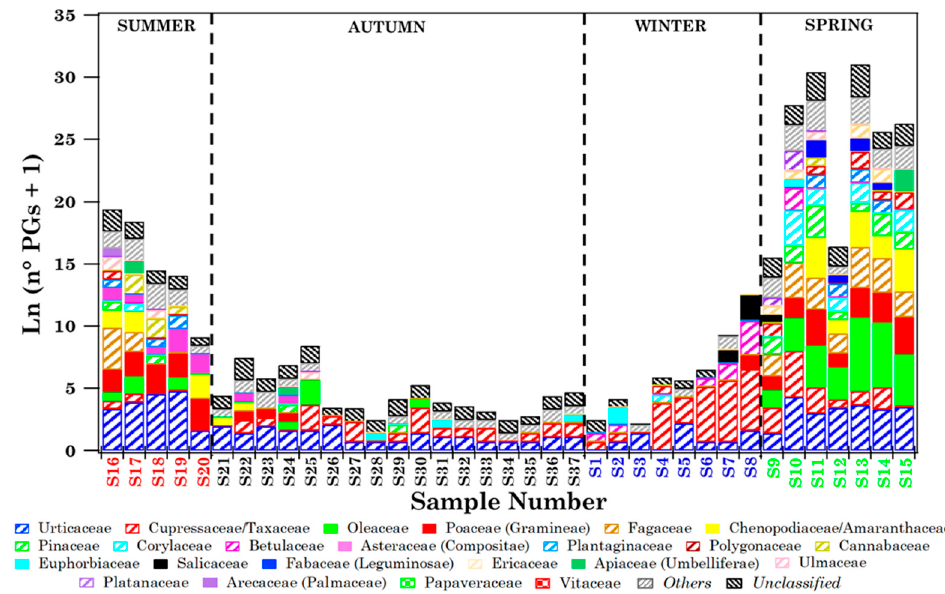
Figure 3. Natural logarithm of the number of pollen grains (n° PGs) + 1, associated with the 21 identified families in each sample collected at Brindisi, in addition to the Others and Unclassified pollen grains. Samples are listed according to the sampling date. Each sample colour indicates a different season (red: summer, black: autumn, blue: winter, green: spring).